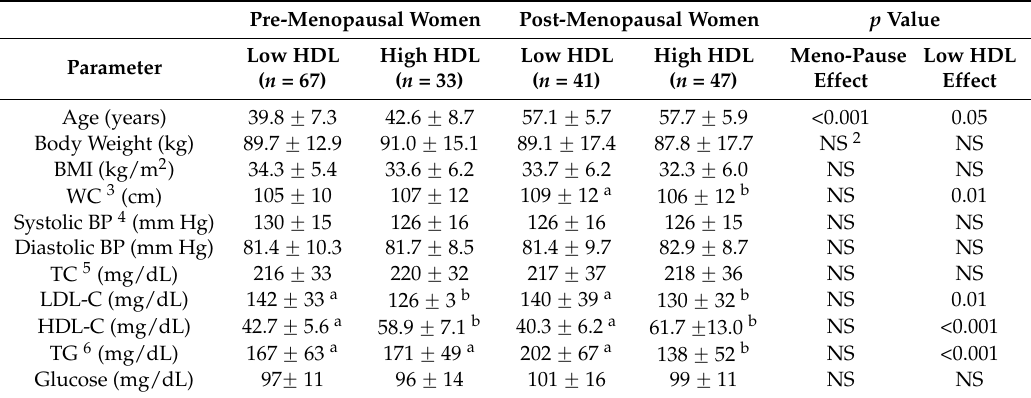
Table 2. Distribution of pre and post-menopausal women into Low HDL and High HDL groups 1 .